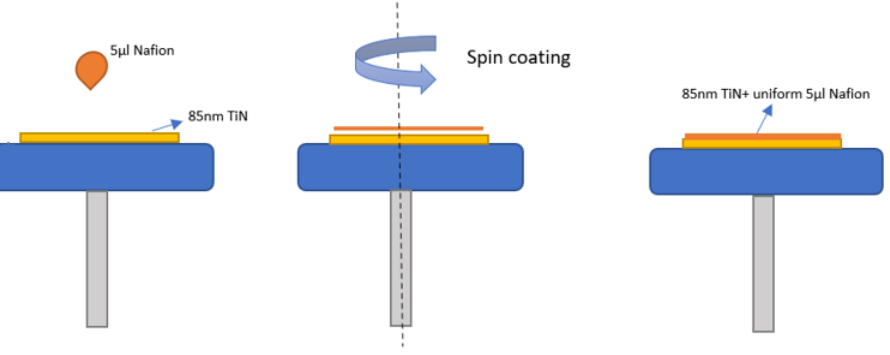
Figure 3. Schematic showing deposition of Nafion membrane on 85 nm TiN electrode using spin coating.